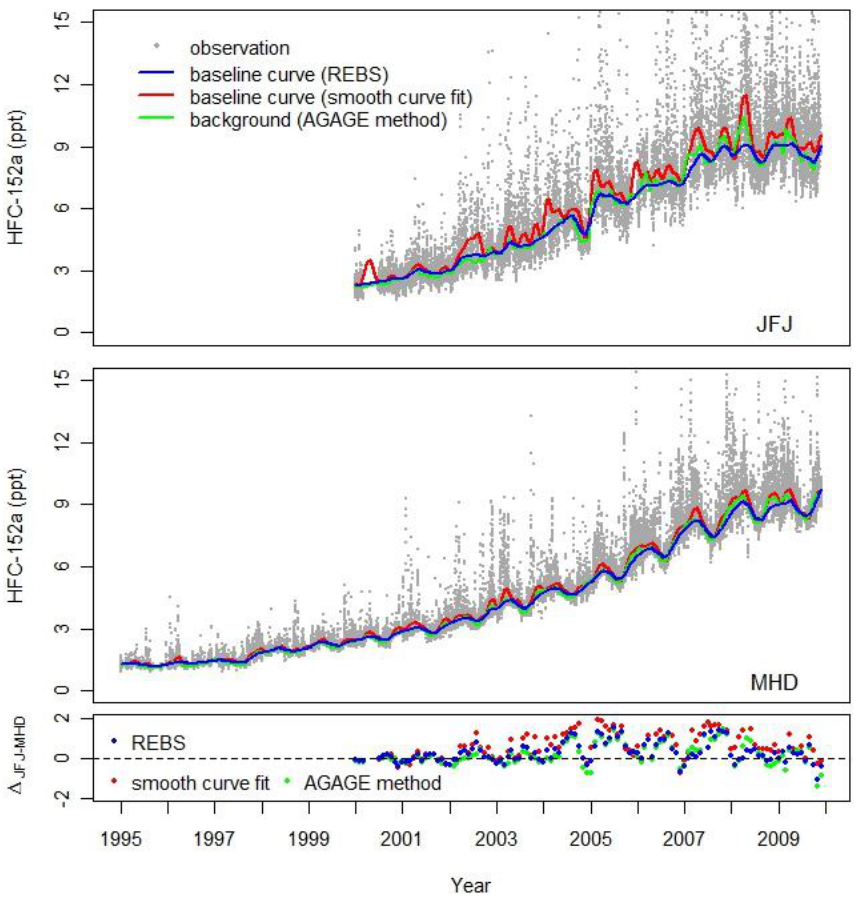
Fig. 4. Measurements and baseline curves for HFC-152a at Jungfraujoch (2000 to 2009, top panel) and Mace Head (1995 to 2009, middle panel) estimated with the REBS technique and the smooth curve fit. The time series of monthly mean background concentration of HFC-152a calculated with the AGAGE method (see text) are also included. The lower panel gives the difference of monthly background concentrations at Jungfraujoch and Mace Head (in ppt) as determined with the REBS, the smooth curve fit, and the AGAGE